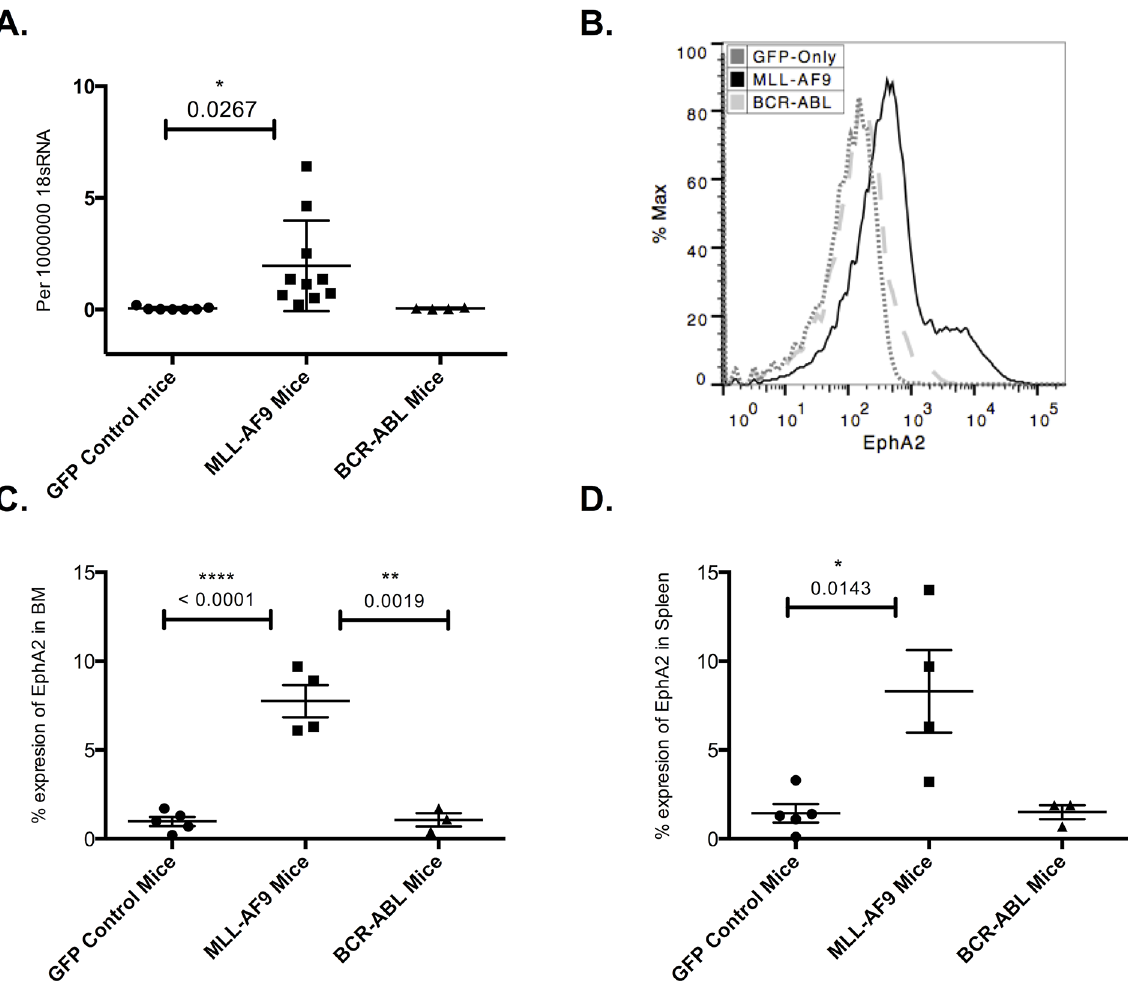
Fig 4. Analysis of EphA2 protein and RNA expression on GFP-control, MLL-AF9 and BCR-ABL bone marrow and spleen. ( A ) EphA2 mRNA expression levels relative to 18sRNA in bone marrow of GFP-control, MLL-AF9 and BCR-ABL mice, analyzed per 1000000 18s RNA using RT-PCR. Significantly higher EphA2 expression (P = 0.0267) in the MLL-AF9 bone marrow compared to GFP-control mice. ( B ) Representative flow cytometric overlay analysis of the EphA2 expression in GFP-control, MLL-AF9 and BCR-ABL bone marrow. ( C ) Flow cytometric analysis of the EphA2 expression in bone marrow of GFP-control, MLL-AF9 and BCR-ABL mice measured as mean fluorescent intensity, showed significantly higher EphA2 expression on MLL-AF9 bone marrow compared to GFP-control bone marrow (P < 0.0001) and compared to BCR-ABL leukemic bone marrow (P = 0.0019) (n = 5 GFP-control, n = 4 MLL-AF9, n = 3 BCR-ABL, 1 biological replicates, 2 technical replicates). ( D ) Flow cytometric analysis of the EphA2 expression in spleen of GFP-control, MLL-AF9 and BCR-ABL mice measured as mean fluorescent intensity, showed significantly higher EphA2 expression in spleen of the MLL-AF9 mice compared to GFP-control mice (P = 0.0143) and higher expression compared to BCR-ABL leukemic mice (n = 5 GFP-control, n = 4 MLL-AF9, n = 3 BCR-ABL, 1 biological replicates, 2 technical replicates). Each dot corresponds to one individual mouse. The data represent the mean ± SEM. Unpaired t test was performed for statistical